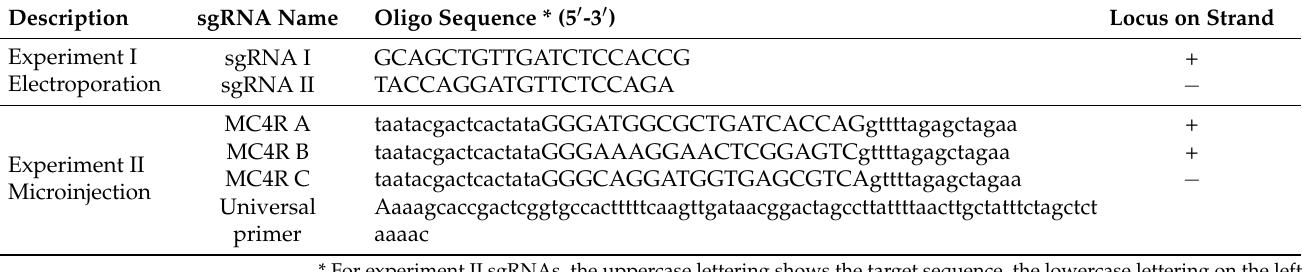
Table 1. The sequences of small guided RNAs and the universal (common) primer used to target